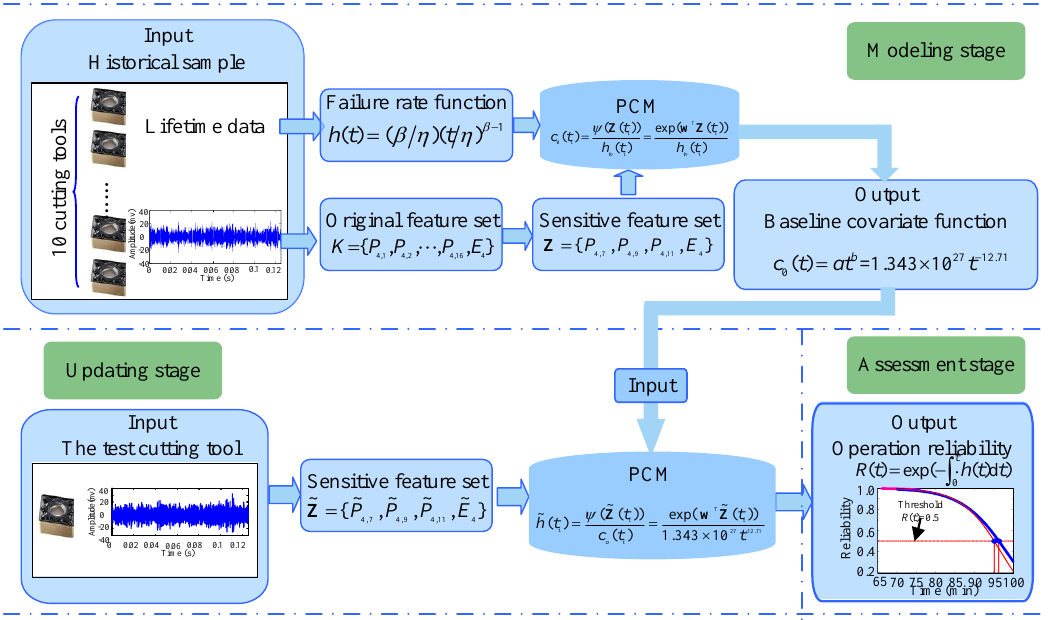
Figure 11. Input/output relationship of the proposed